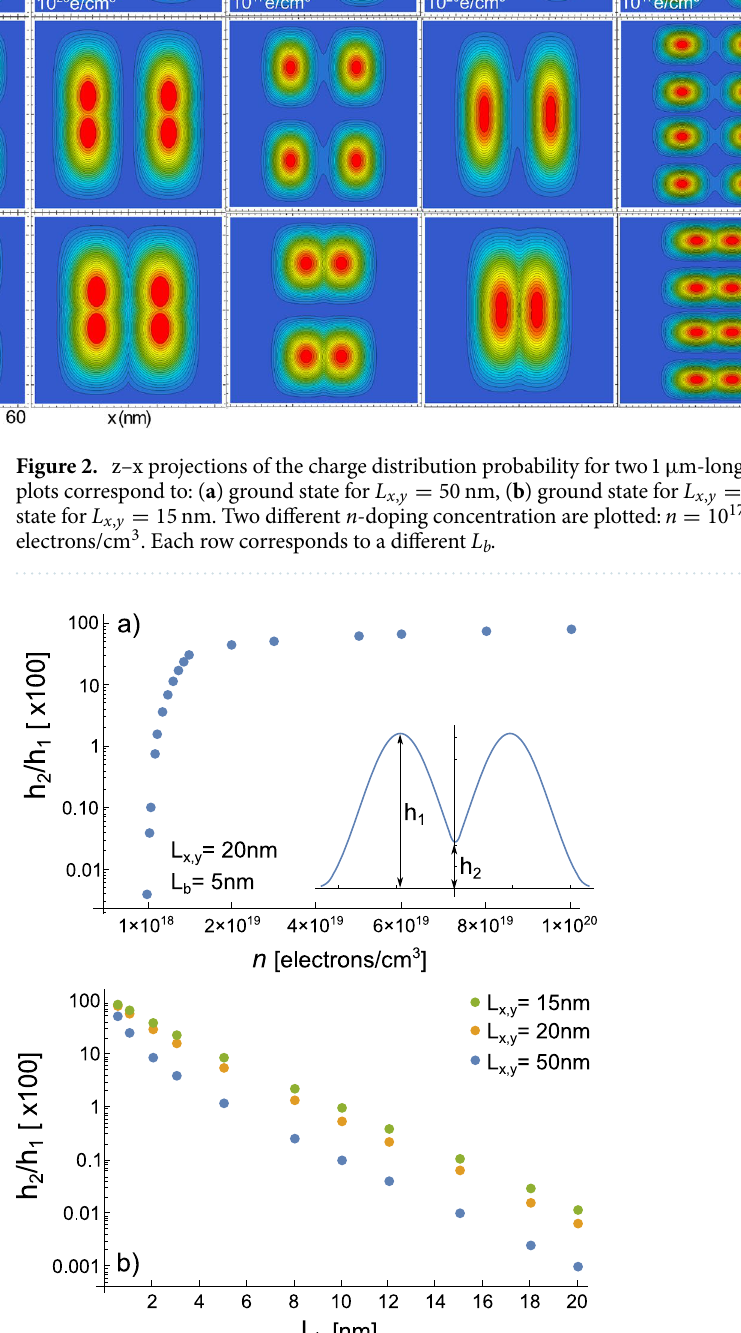
2 PNW with L 20 nm and Figure 3. ( a ) h 2 / h 1 dependence on the electron density n for an array of 1 x , y = × 5 nm. ( b ) h 2 / h 1 dependence on L L b b for a similar array for three different cross sections L x , y . We use the = h 2 / h 1 ratio as a parameter to describe the tunneling strength between localized distributions. Here h 1 and h 2 are heights taken from 2D electron distribution profiles as illustrated in the inset in ( a ). In ( a ), the profiles are taken along the z -axis from one of the NWs while in ( b ), the profiles are taken across the NWs along the x